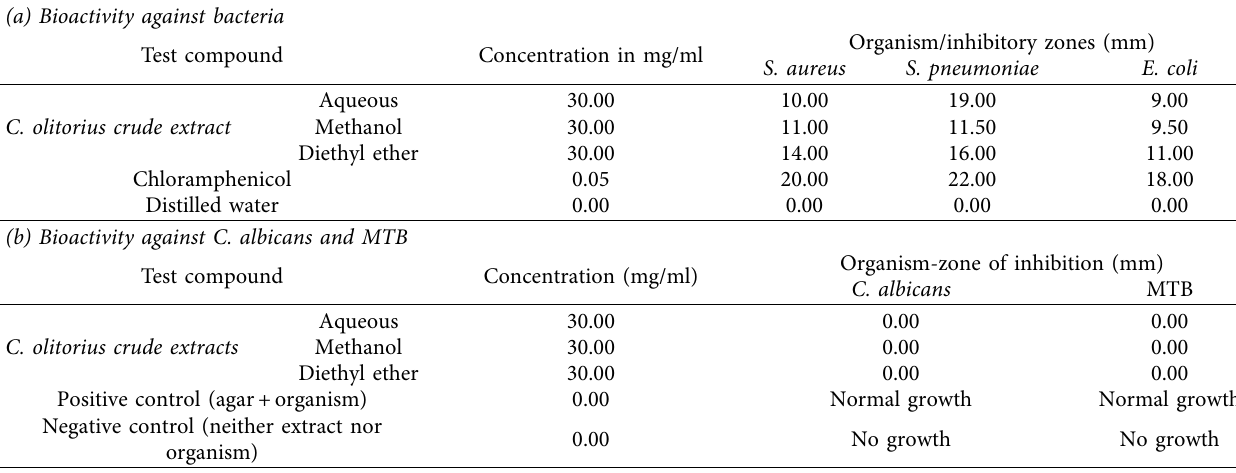
Table 1: Bioactivity of C. olitorius crude leaf extracts; mean zones of inhibition